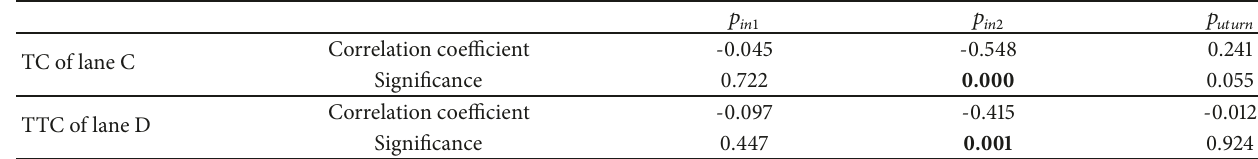
Table 4: Correlation matrix for